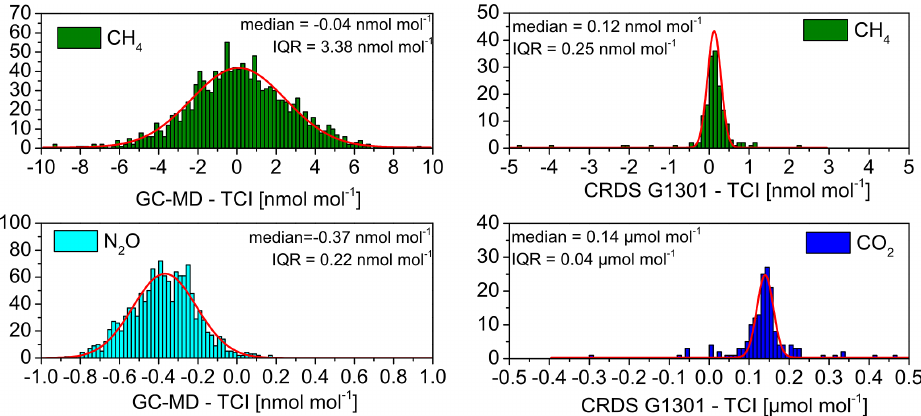
Figure 7. Left panels: distribution of the differences in CH 4 and N 2 O between the discrete GC-MD measurements and the corresponding 3-minute averaged values of the TCI at Mace Head from 6 March 2013 until 1 May 2013 (both instruments with separate intake lines at a height of 10m). Right panels: distribution of the differences between the hourly averaged CH 4 and CO 2 differences between the CRDS G1301 and the TCI from 1 May 2013 until 6 May 2013 (both instruments with separate intake lines at a height of 25m). The red curves are Gauss fits to the